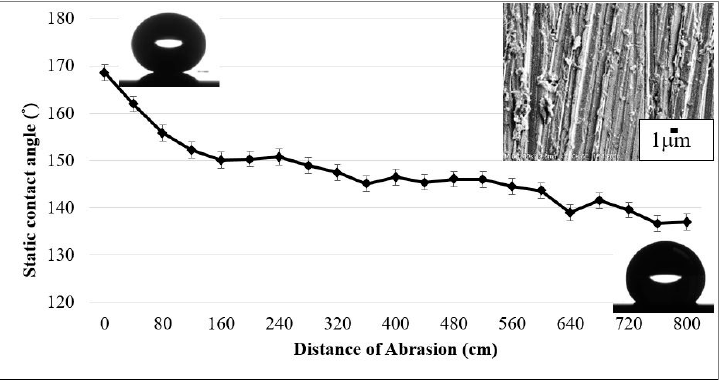
Figure 7. Water contact angles as a result of the abrasion against a 5000 grit sand paper with 7.75 kPa normal load. The inset SEM image (upper right) shows surface morphology after reaching 800 cm of abrasion length.